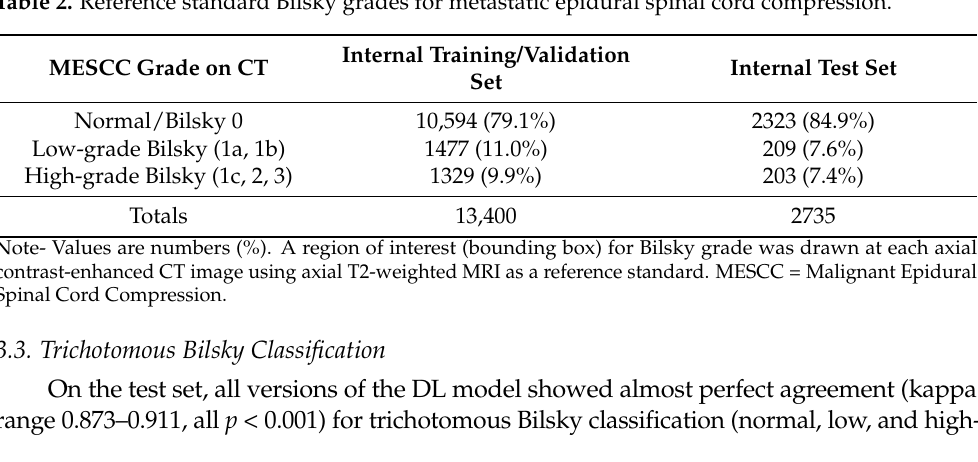
Table 2. Reference standard Bilsky grades for metastatic epidural spinal cord